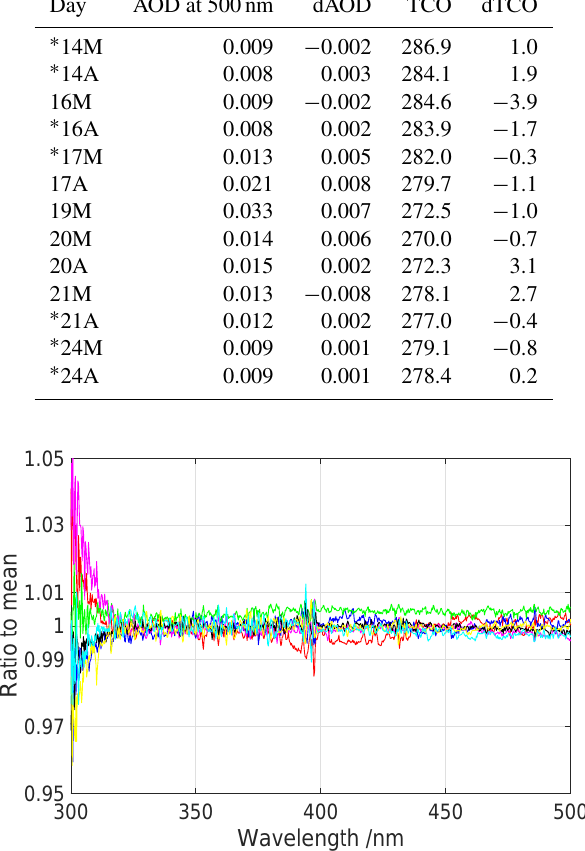
Figure 2. Ratio between solar spectra obtained from direct irradi- ance measurements with the QASUME spectroradiometer to their average during 7 half-days for the period 14 to 24 September